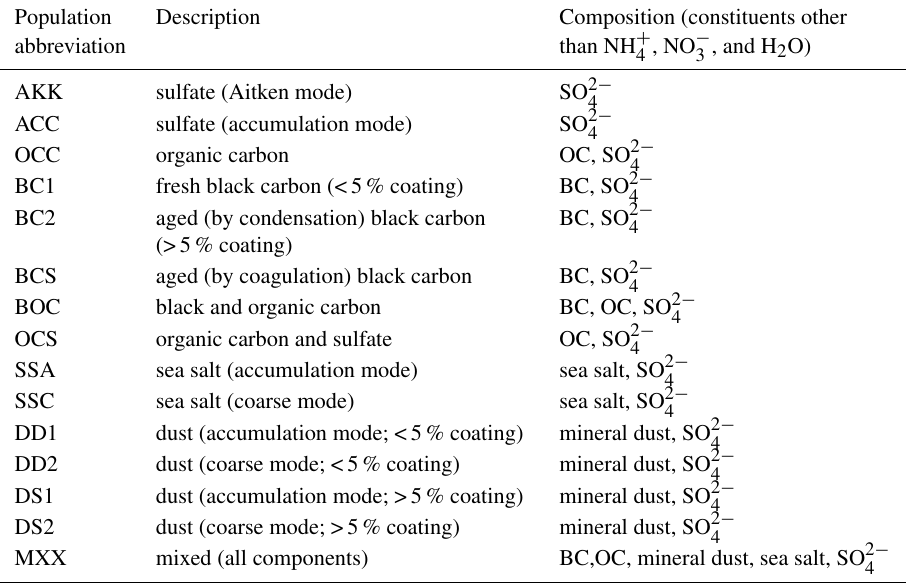
Table 2. Aerosol population chemical composition in MATRIX.